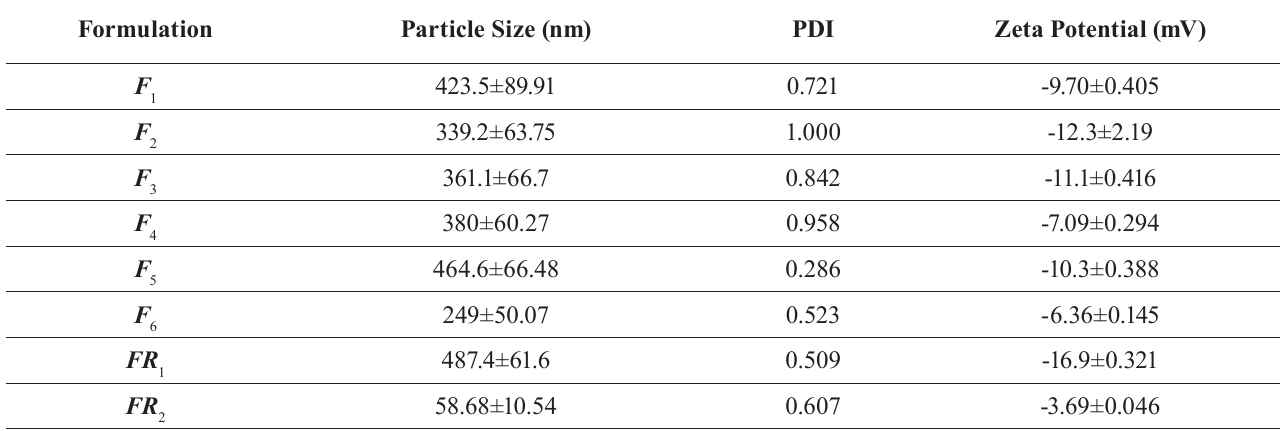
TABLE II - Particle size, PDI and Zeta potential of the VEGF-free and VEGF loaded PCL nanoparticles